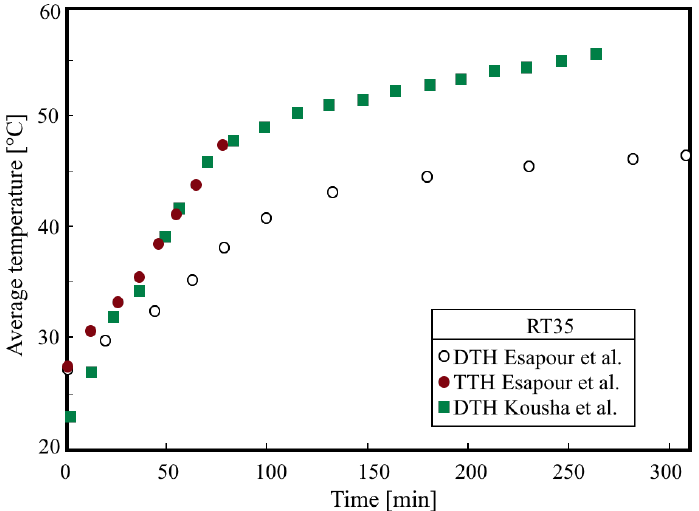
Figure 11. Comparison of PCM temperature for DTH and TTH [52,90].